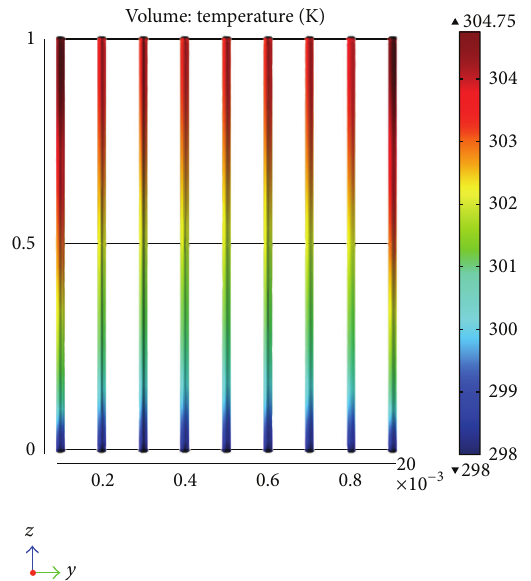
Figure 11: The temperature distribution within the pipes.